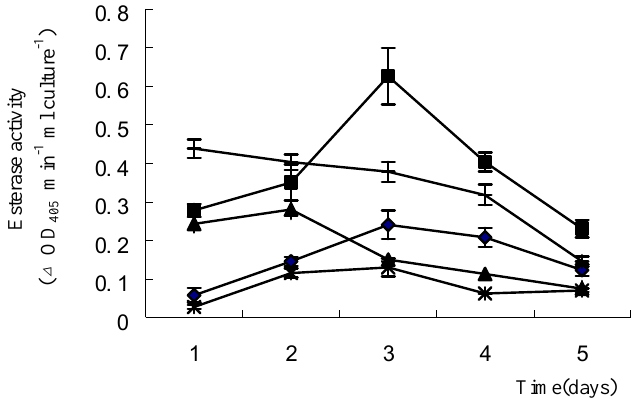
Figure 3. Induction of C. eragrostidis esterase activity by plant waxes in Czapek medium. 5 ml of conidium suspension in C. eragrostidis (10 6 conidia /ml) was added to the medium and cultured for 5 d. Conidia of C. eragrostidis was inoculated in inorganic medium ( (cid:1) ), mineral medium with epicuticular waxes (20 mg/200 ml) of D. sanguinalis ( ■ ), mineral medium with epicuticular waxes (20 mg/200 ml) of F. arundinacea ( ▲ ) and mineral medium with 20mg of 16-hydroxyhexadecanoic acid (+) and palmitic acid. ( (cid:1) ). Results indicate the mean of three different cultures sampled in a single